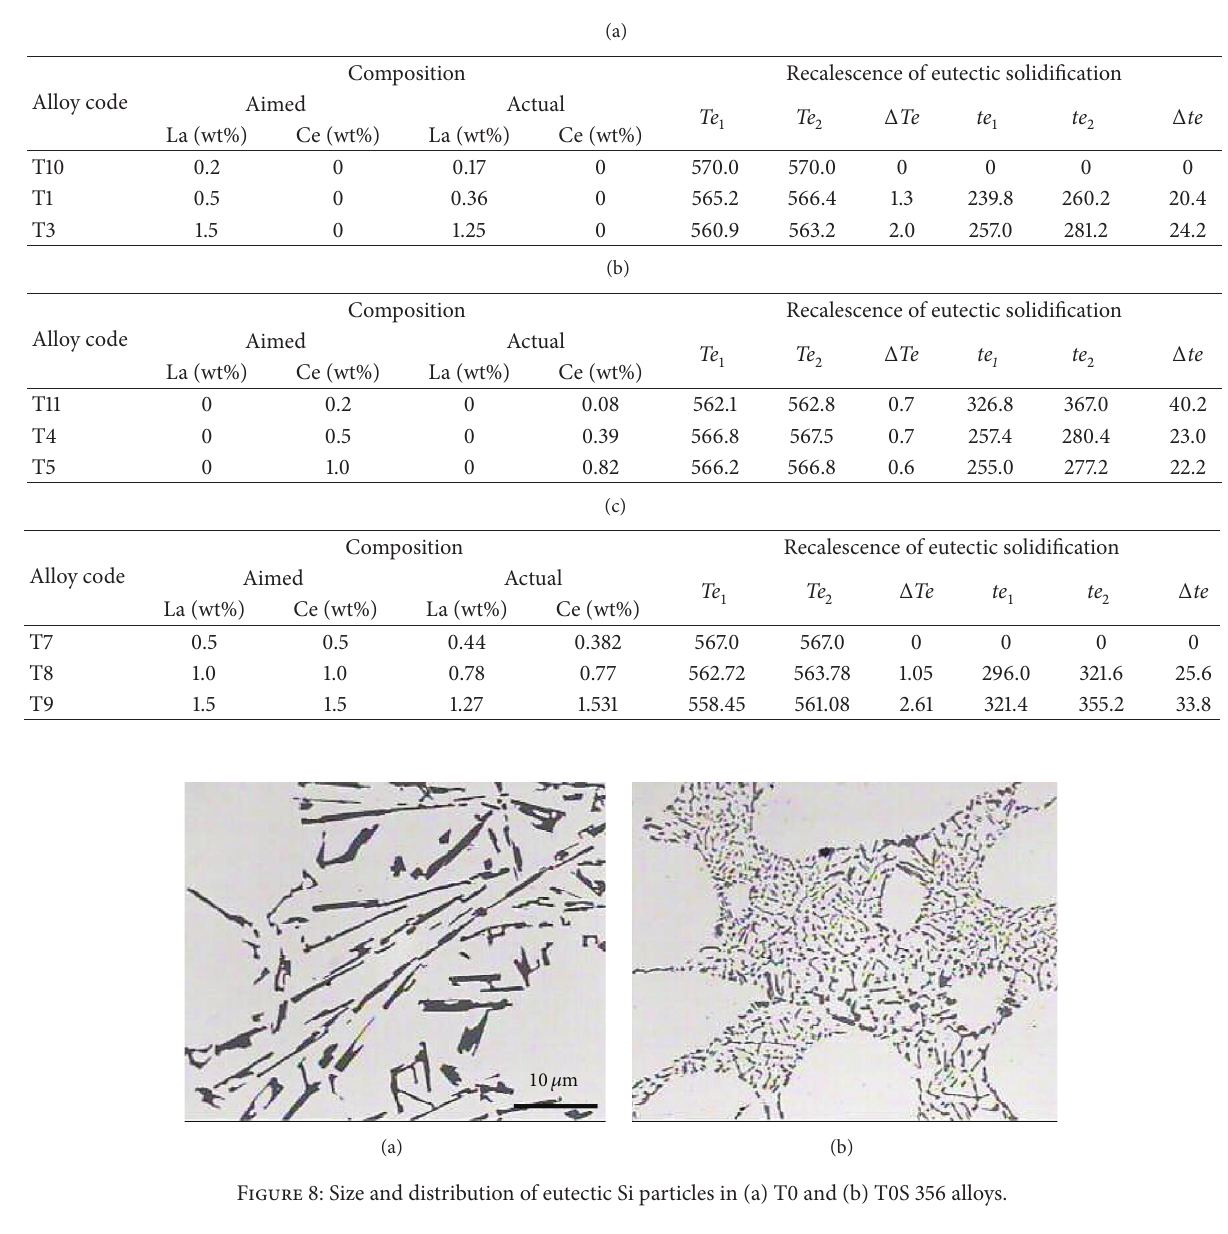
Table 4: (a) Effect of La on recalescence observed in 356 alloy. (b) Effect of Ce on recalescence observed in 356 alloy. (c) Effect of La and Ce on recalescence observed in 356 alloy.